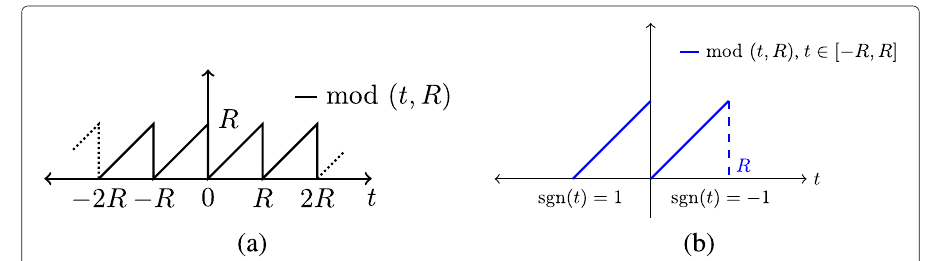
Fig. 1 a The modulo transfer function. b The modulo function limited to 2 modulo periods—a specific case that we consider in this